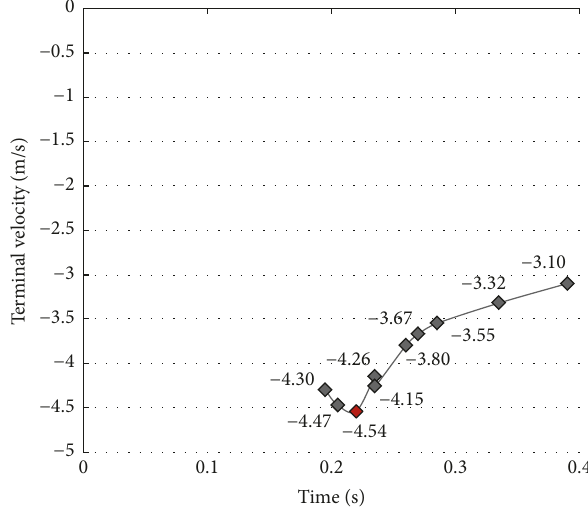
Figure 15: Terminal velocity of conical pounder with different drop heights versus